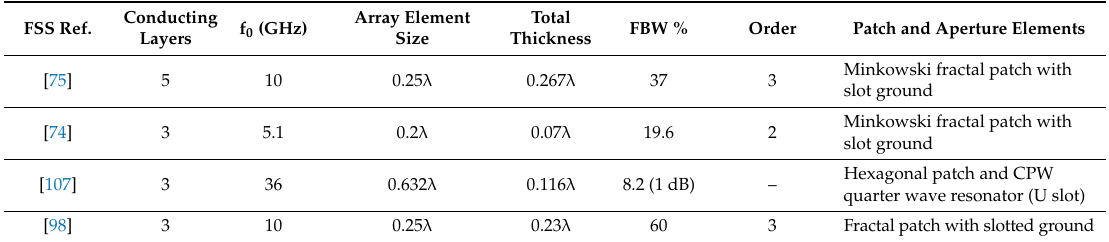
Table 5. Comparison of Antenna-Filter-Antenna fractal FSS structures. FSS